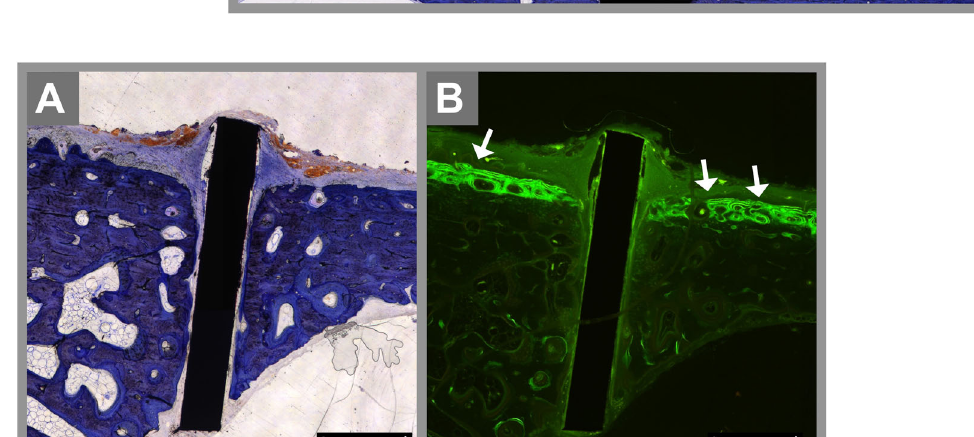
proves the existence of newly formed bone tissue at the surface of the nasal bone (arrows in B ); in contrast, there is nearly no fl uorescence enrichment at the bone – implant interface in the osteotomy, resulting in a low bone-to-implant contact ratio. The scale bar is 1000